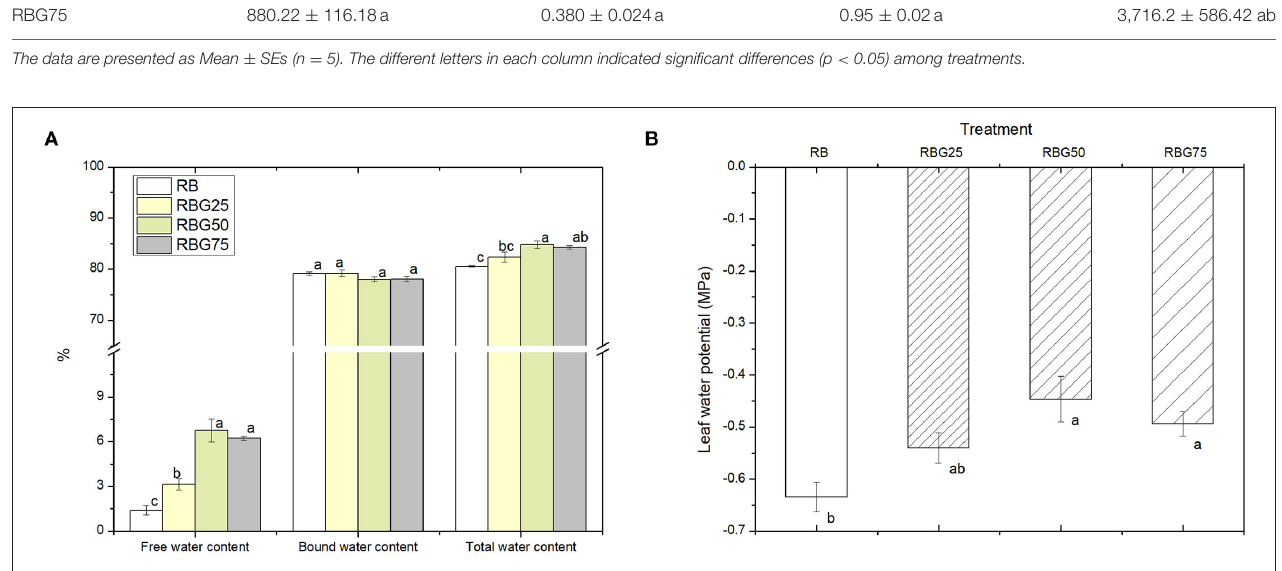
of blue light and red light-induced stomatal closure increased ( Figure 7 ). The stomatal aperture under RBG25, RBG50,